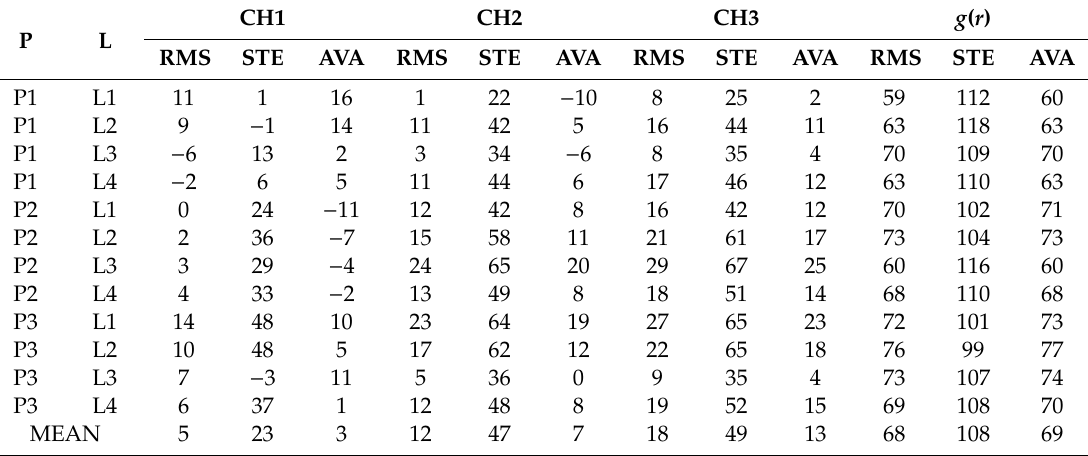
Table 5. Kullback-Leibler distances in decibels (dB) ( d kl (dB) = 10*log 10 ( d kl )).